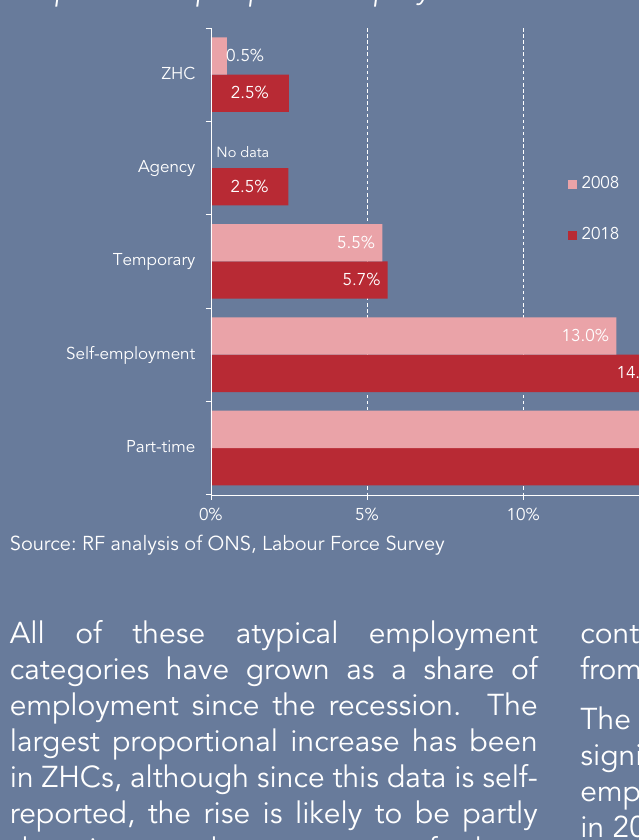
Figure 27: Part-time work is the largest type of ‘atypical’ work Proportion of people in employment with a second job, 16+ year